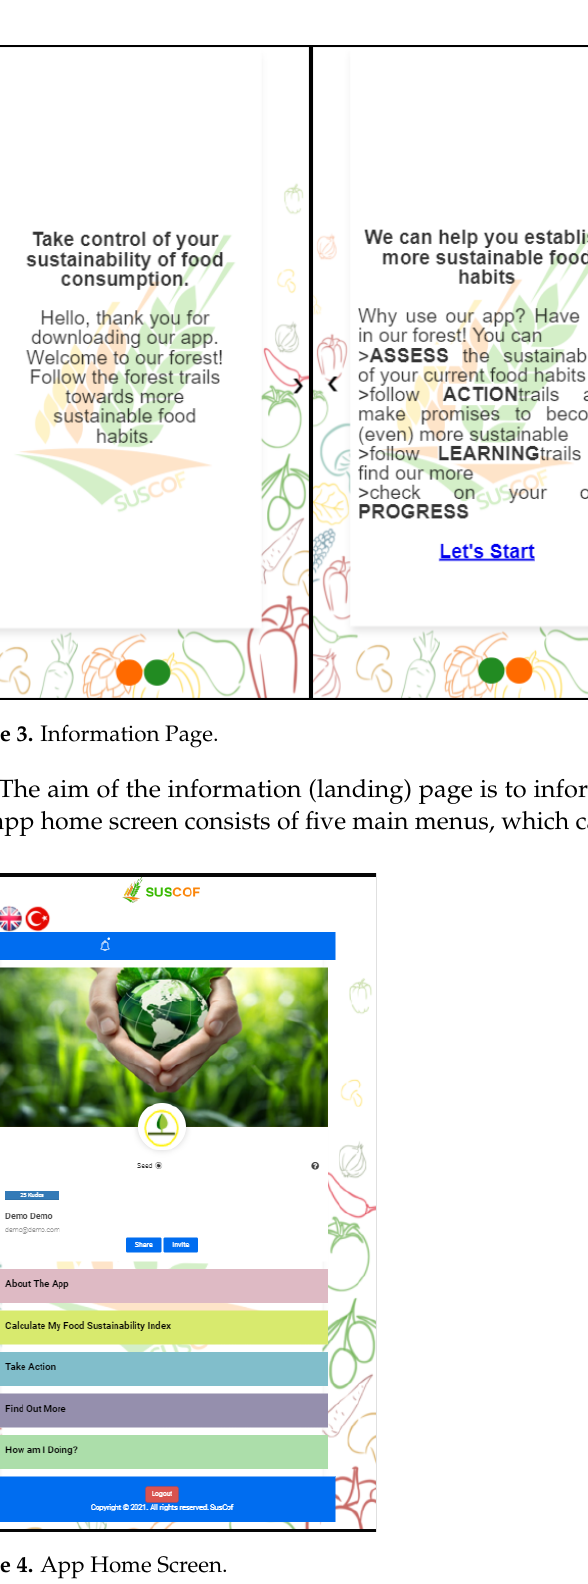
Figure 2. Kudos Grade List.